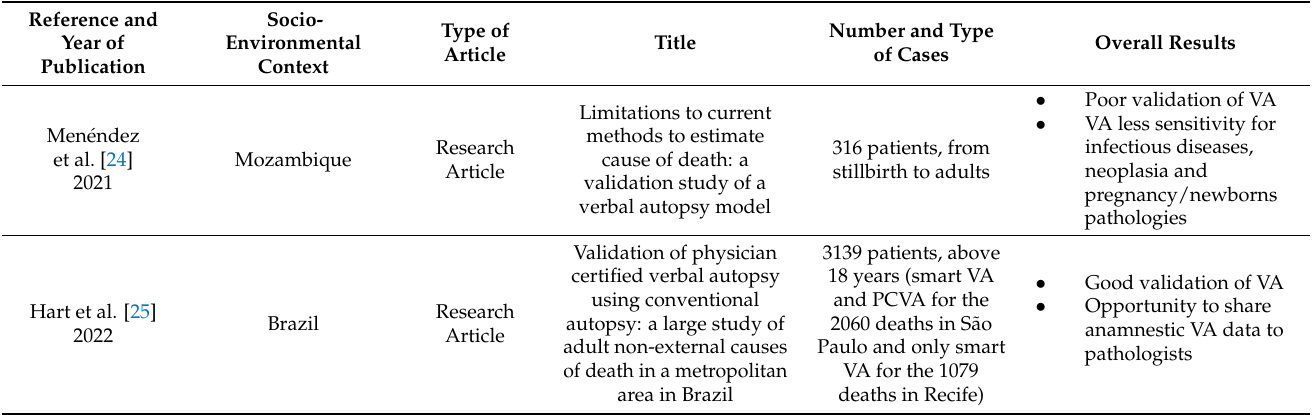
Table 2. Summary of the content of the 2 articles included in the